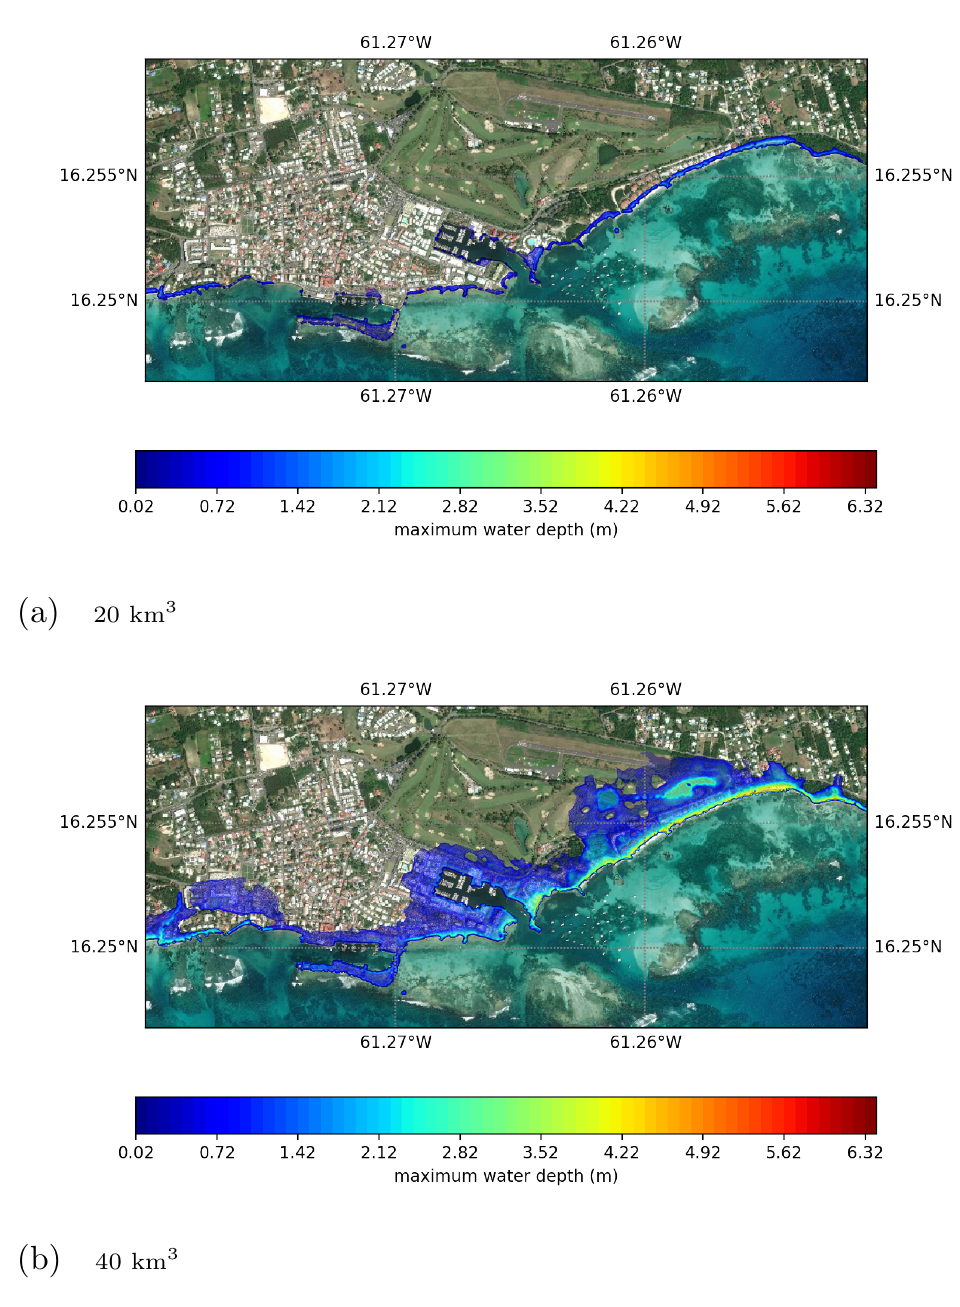
Figure 6. Maximum water depth in the area of Saint-François, Grande-Terre for the 20 and 40 km 3